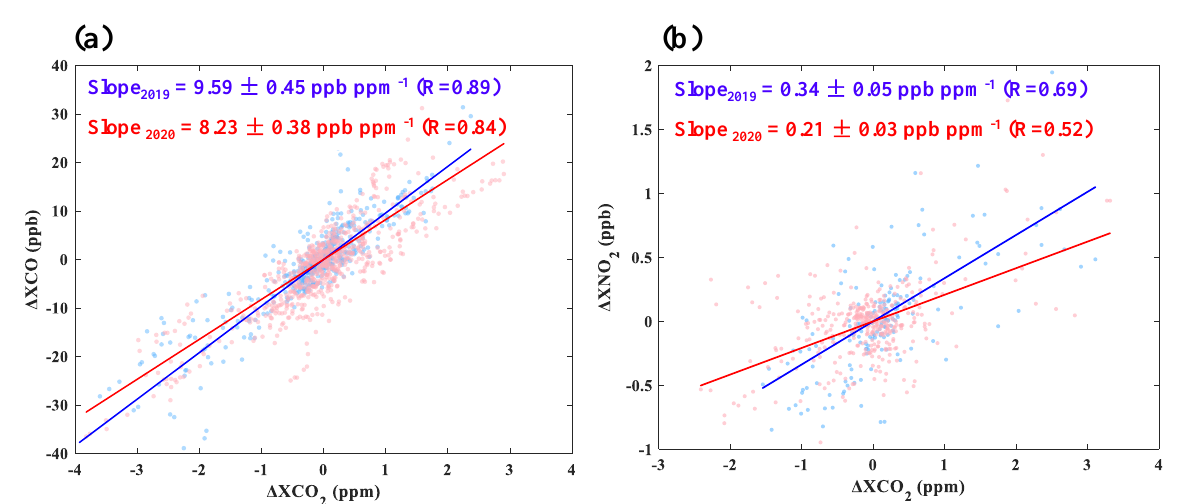
Figure 4. Correlations of ∆ XCO ( a ), ∆ XNO 2 ( b ), and ∆ XCO 2 in 2019 (blue) and 2020 (red); slope2019 and slope2020 represent